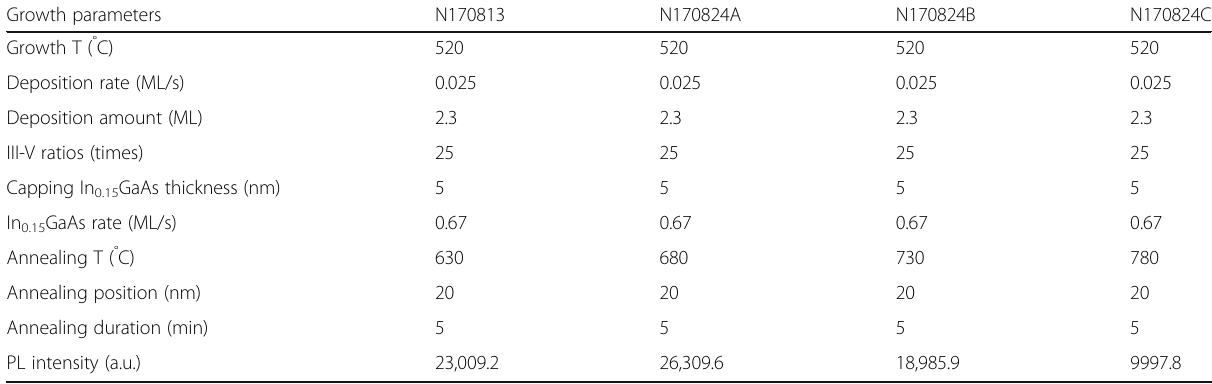
Table 1 Comparison of several types of growth parameters and annealing